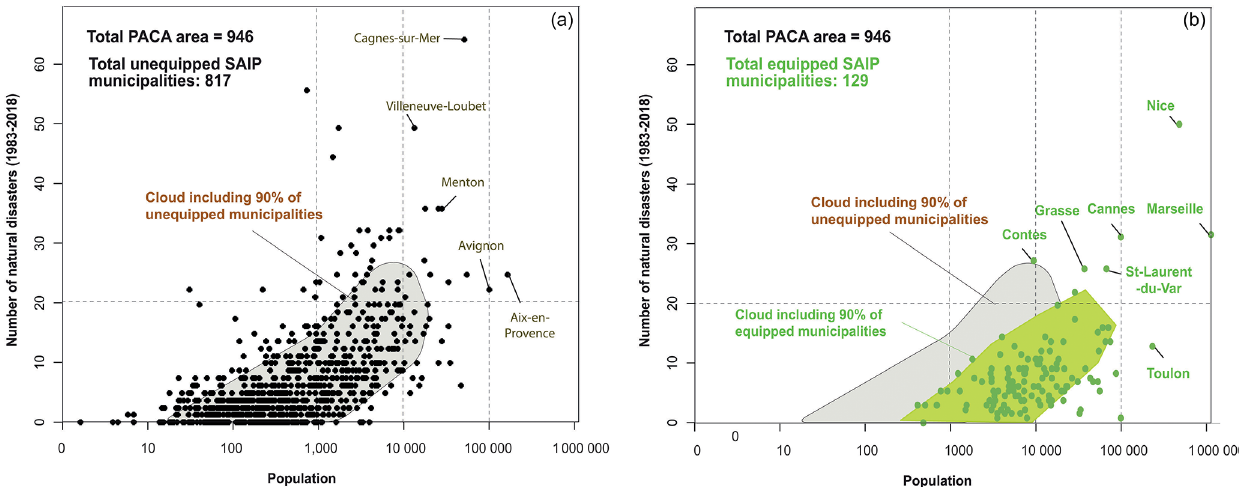
Figure 6. The number of times that CatNat post-disaster funds have been granted to cities of the PACA region, equipped (b) and un- equipped (a) with SAIP sirens, ordered by the population log